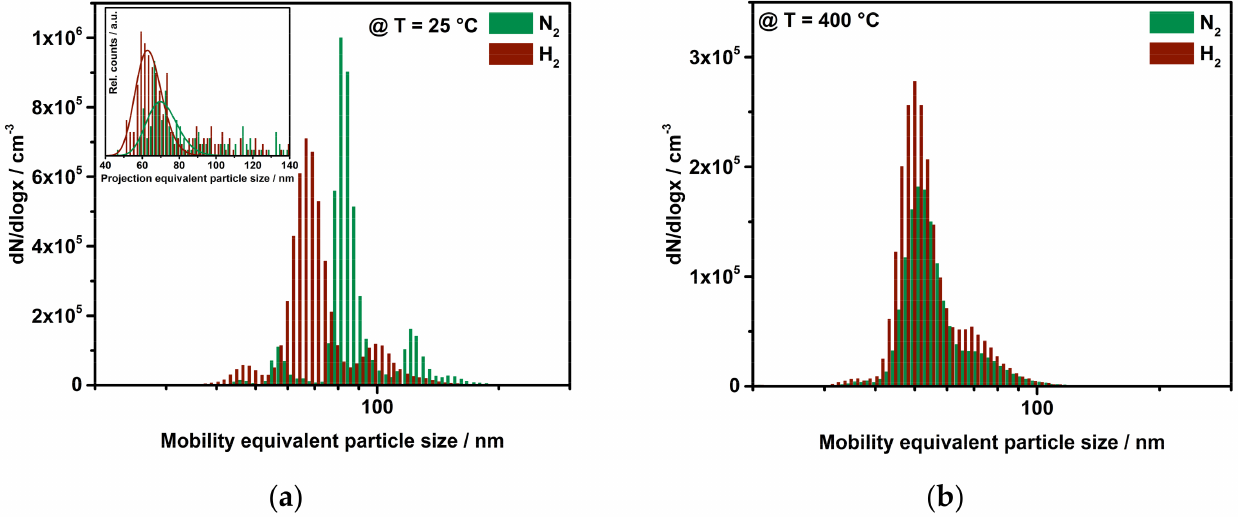
Figure 5. PSD obtained from tandem DMA. ( a ) A hydrogen gas treatment results in a shift to smaller agglomerates. The inset shows the projection equivalent diameter, acquired by TEM analysis, confirming a compaction. ( b ) Particles that underwent sintering at 400 ◦ C are assumed to be mechanically reinforced and, therefore, unaffected by